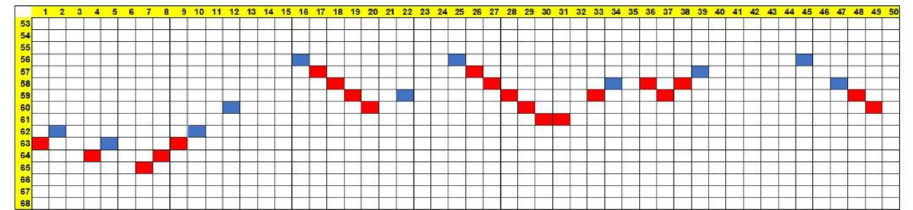
Figure 5. (Colors on line) Active (AP) cells arrivals at the end row of the matrix for a specific trial of a 50 × 50 fibrotic tissue ( p = 75%). Abscissa – No. of cell along the row, Ordinate—Time of arrival (time units from wave starting